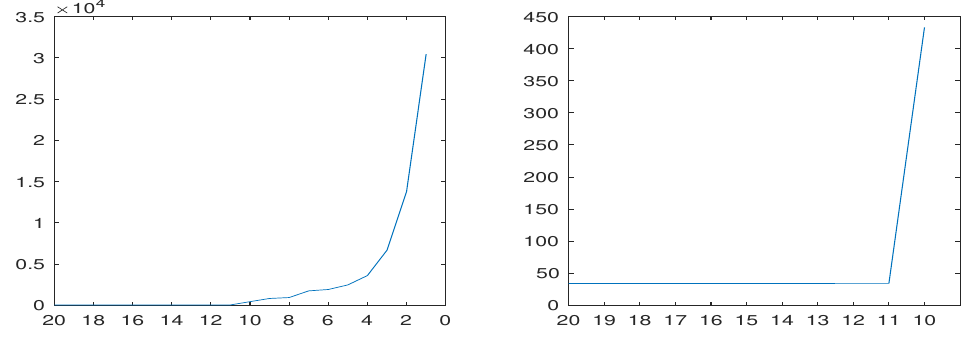
Figure 10: Left side: | λ 20 ( A n ) | < ··· < | λ 1 ( A n ) | ; right side: | λ 20 ( A n ) | < ··· < | λ 10 ( A n ) | in a typical realization in case (b) of Example